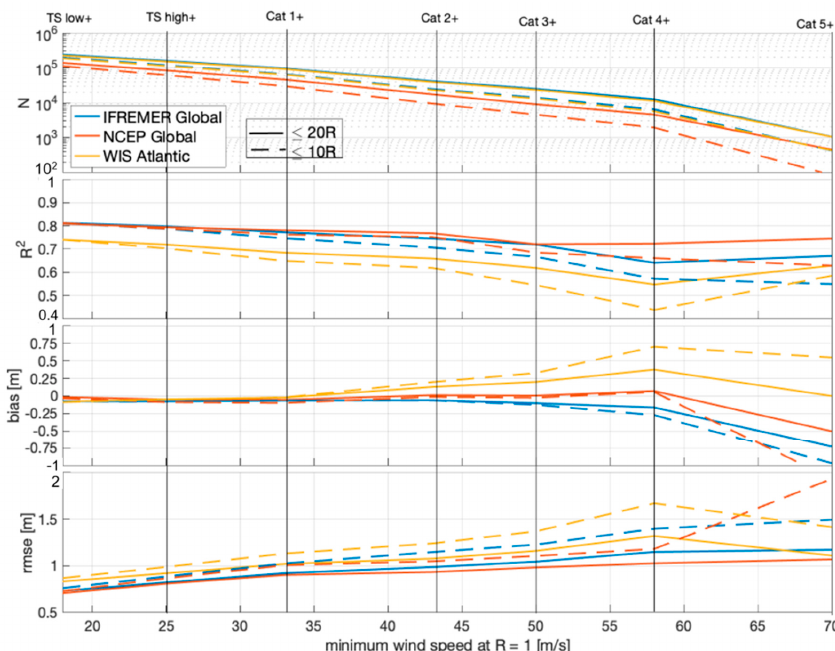
Figure 5. Error statistics for each operational hindcast, Ifremer in blue, NCEP in red, and WIS in yellow. Solid lines are for data within 20R of an LPS, and dashed lines are for data within 10R of an LPS. The x-axis is the minimum required wind speed of the LPS. S-S status is indicated by vertical lines. From top to bottom is the number of comparison, correlation coefficient, bias, and